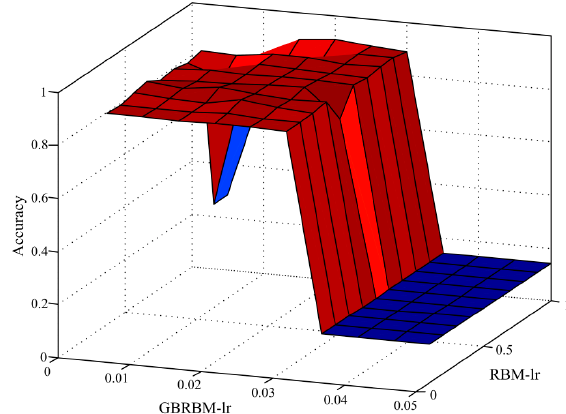
Figure 10. The influence of learning rate on the diagnosis accuracy.